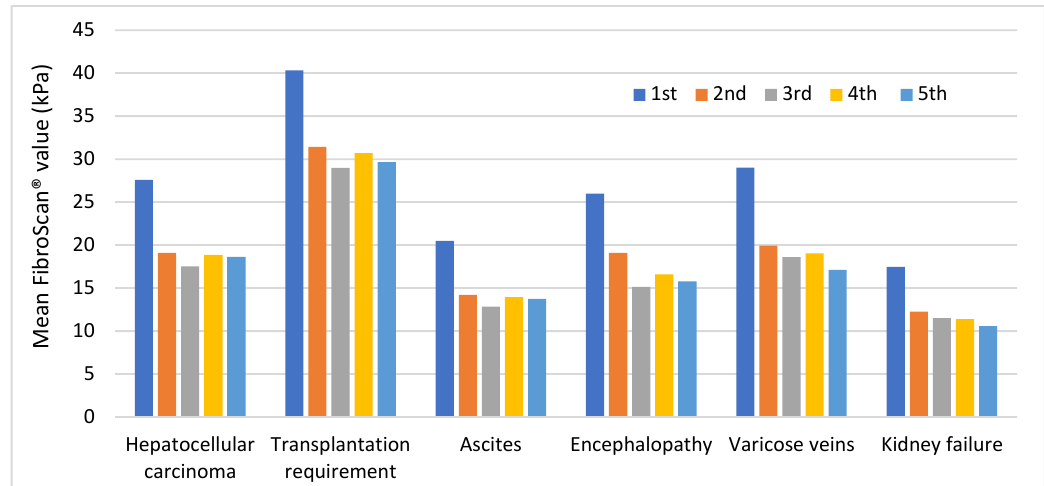
Figure 8. Trend of mean FibroScan ® values in each complication throughout the follow-up period.